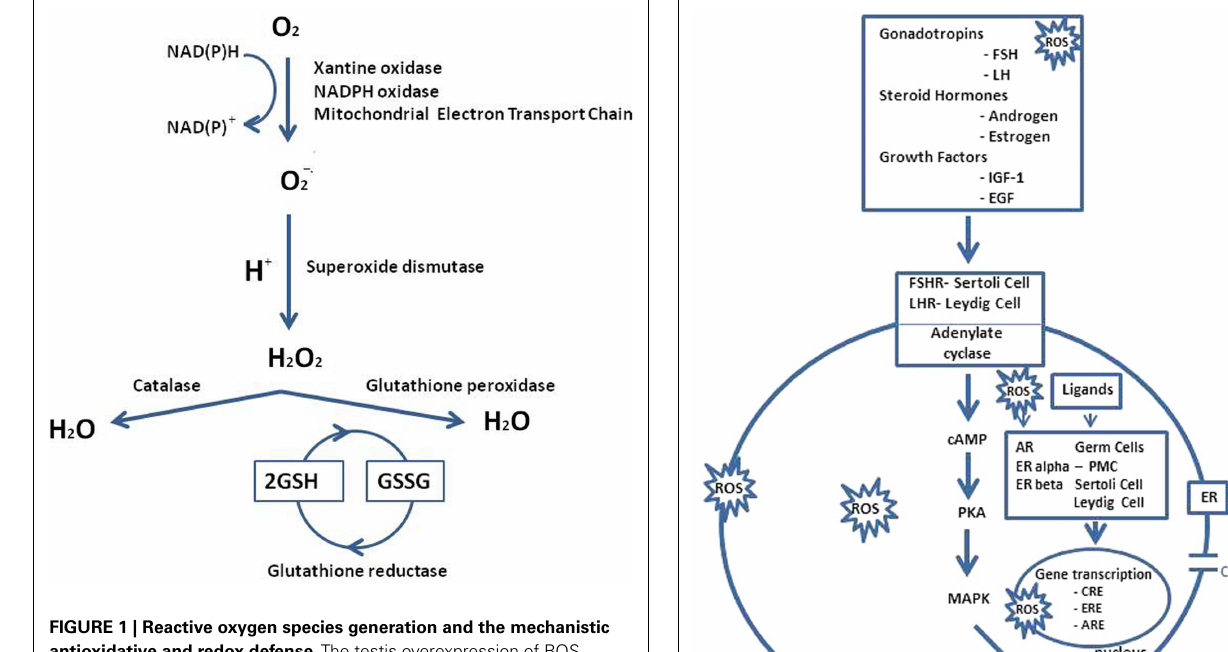
FIGURE 1 | Reactive oxygen species generation and the mechanistic antioxidative and redox defense .The testis overexpression of ROS accelerates a response by the superoxide dismutase (SOD), glutathione peroxidase (GPx), and the glutathione- S -transferase (GST).The resulting oxidation product is recycled by glutathione reductase (GR), which transforms the oxidized glutathione (GSSG) back to reduced form of glutathione (GSH) [from Ref. (13)].